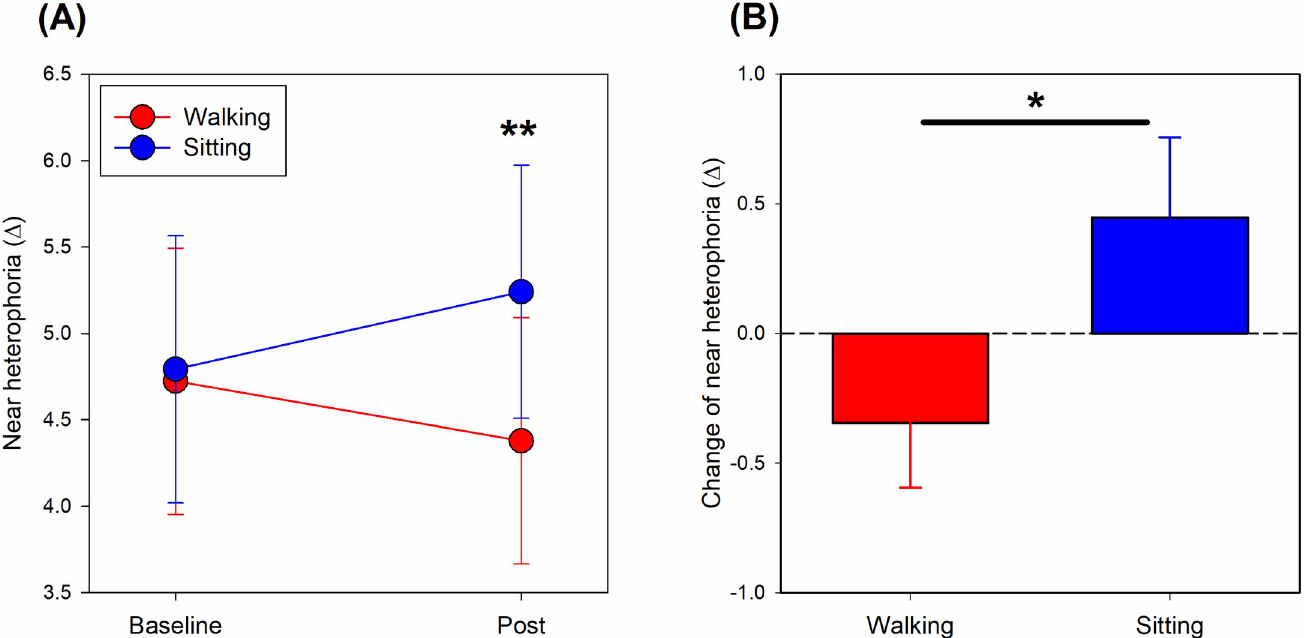
Fig 2. Vergence adaptation following 30 minutes of smartphone use. A) In the post-smartphone use session, near heterophoria showed significantly less exo- deviation (i.e., less positive) after walking than sitting, while no significant difference was found at the baseline. B) Change in near heterophoria showed significantly less exo-deviation (or more eso-deviation) for walking than sitting. Positive: Exo-deviation; negative: Eso-deviation. Red symbols : Walking; Blue symbols : Sitting. Bonferroni post hoc test: �� p < 0 . 01 , paired t-test: � p < 0 . 05 .